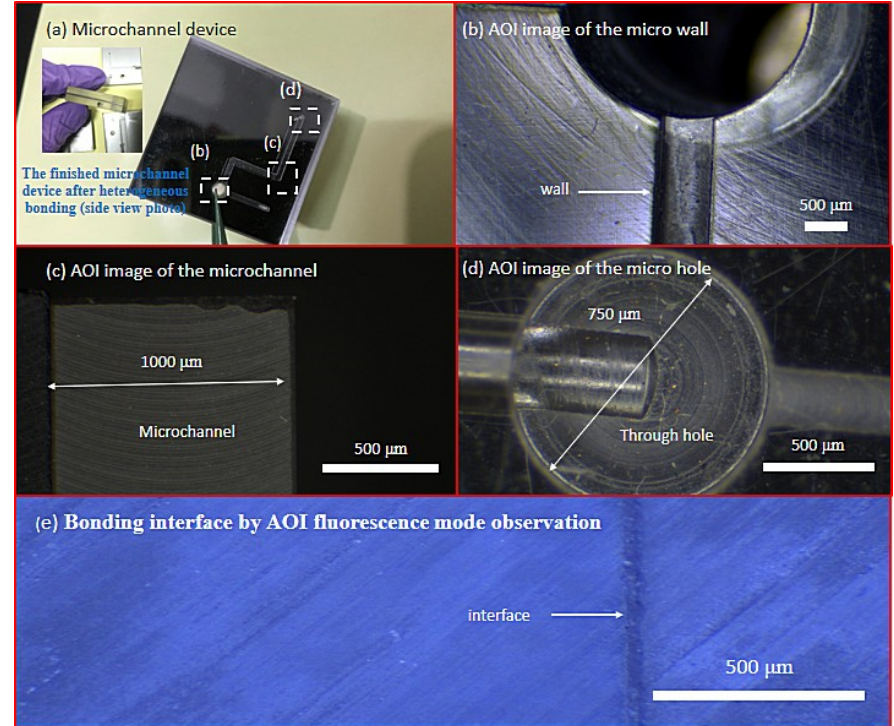
Figure 10. Morphology of the microchannels after heterogeneous bonding was observed by AOI. ( a ) Complete microchannel device fabricated by heterogeneous bonding. ( b ) The morphology of the microchannels and through-holes is smooth and flat, without deformation or leakage in the linking area between the channels and the circular holes. ( c ) The width of the microchannel is 1000 µ m. ( d ) The diameter of the through-hole is 750 µ m, which results in no damage and smooth surface wall. ( e ) Photograph of the interface microchannel in UV fluorescence mode.